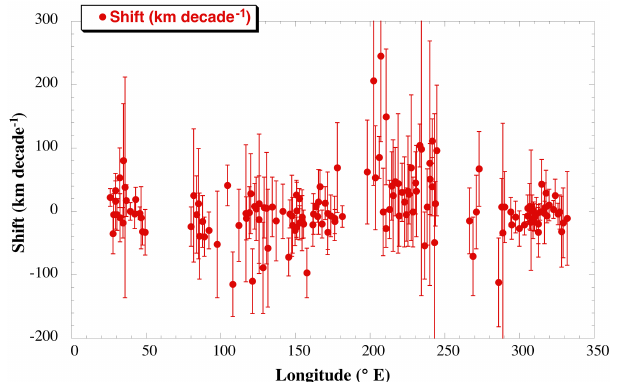
Figure 9. SNR (trend/error in Fig. 8). Values larger than 1 indicate a statistically significant northern shift. Values smaller than − 1 in- dicate a statistically significant southern shift. Values between ± 1 indicate no statistically significant